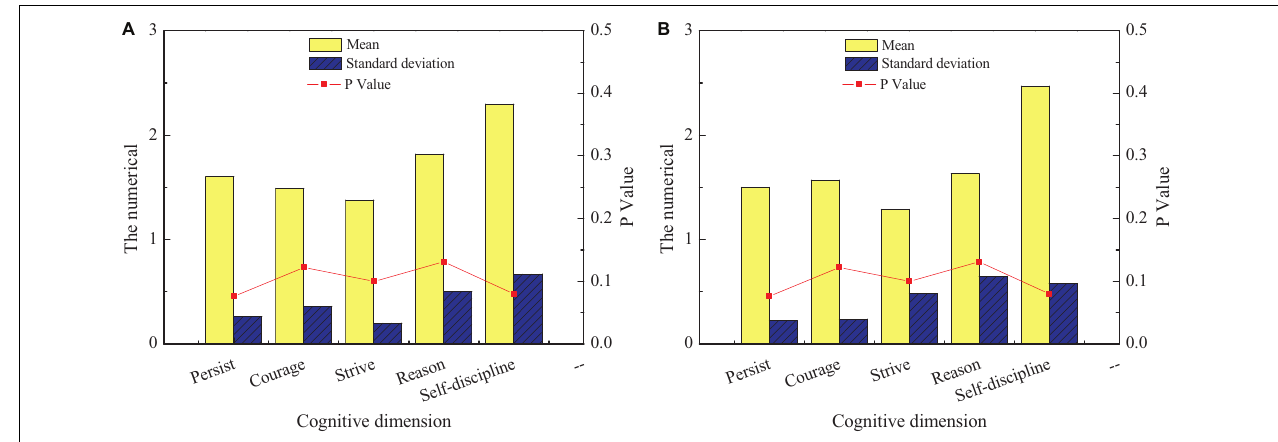
FIGURE 12 | Comparison of entrepreneurial will of students of different genders: (A) men and (B) women.